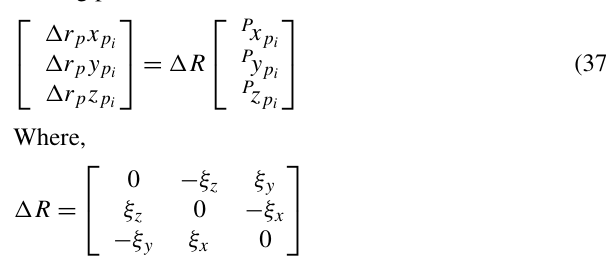
(cid:0) (cid:1) ξ x ξ y ξ z platform, and the is the differential rotation of the moving platform around the three coordinate axes.